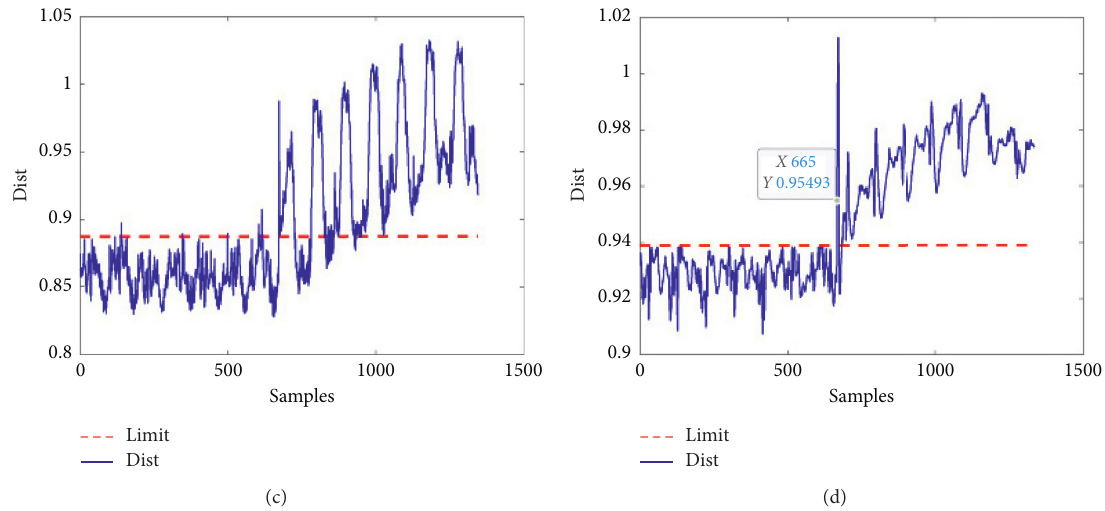
Figure 9: Monitoring results for Case 2 by (a) KPCA, (b) conventional SVDD, (c) LDR-wSVDD, and (d)